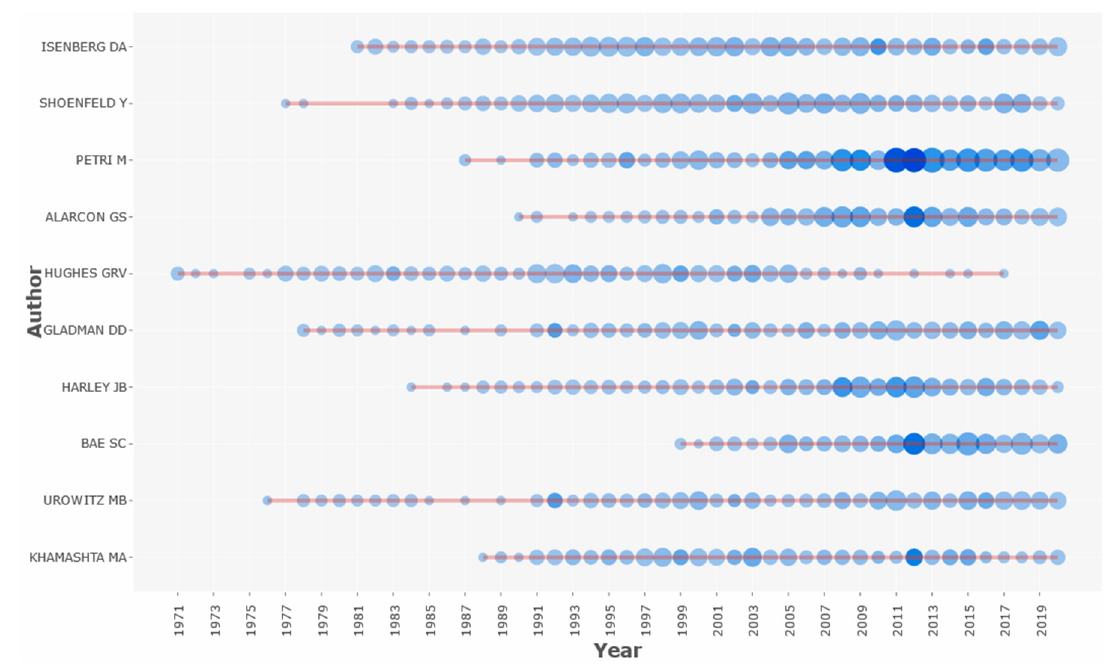
Figure 3. Plot of the top 10 most prolific authors on systemic lupus erythematosus from 1971 to 2020.